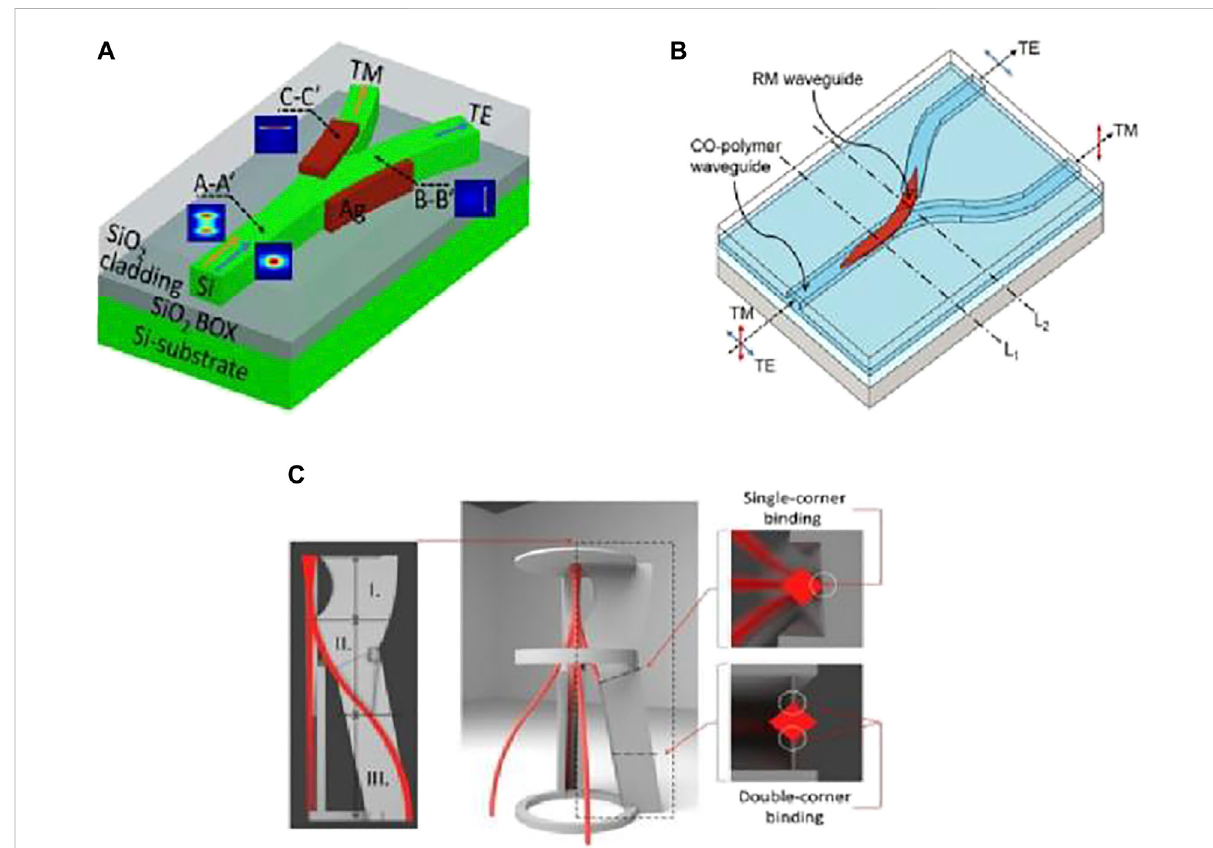
FIGURE 1 Optimal design of y-branch beam splitter. (A) Structural diagram of y-branch polarization beam splitter of hybrid plasma waveguide [35]. (B) Schematic diagram of polarization beam splitter inserted with high birefringence material [36]. (C) Schematic diagram of 3D polymer beam splitting using laser direct writing technology [48]. Figure reproduced with permission from: (A) , © 2016, Institute of Electrical and Electronics Engineers (IEEE); (B) , © 2017, Nature Portfolio; (C) , © 2021, Institute of Electrical and Electronics Engineers